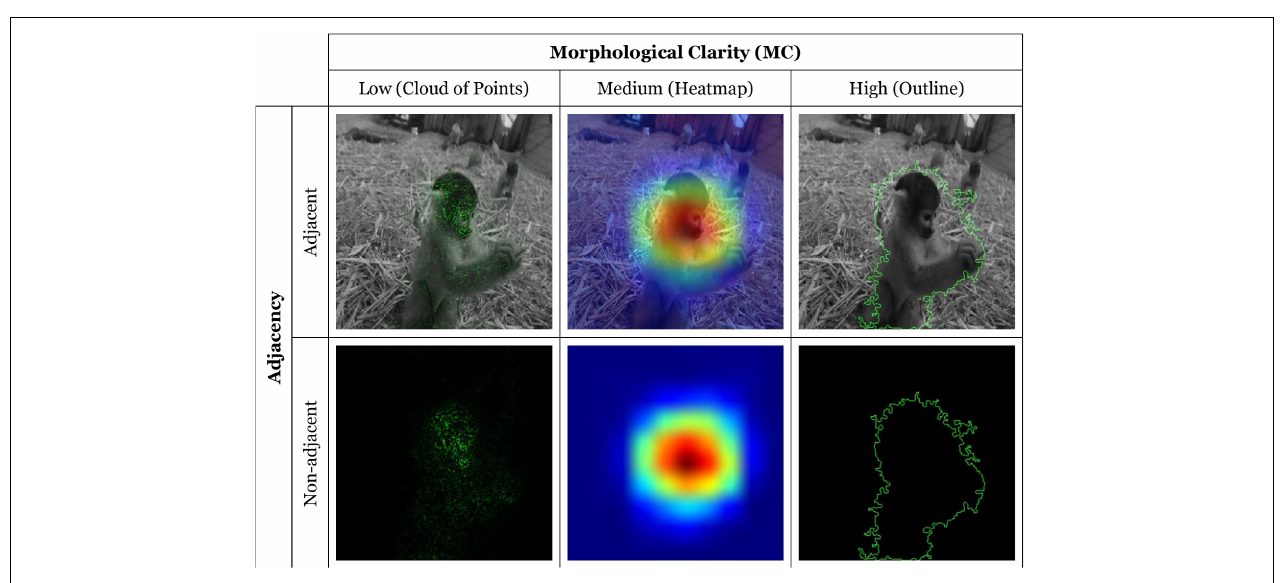
FIGURE 4 | Example of each type of EV for the classification “Monkey”. Images selected from the ImageNet dataset (Deng et al., 2009).